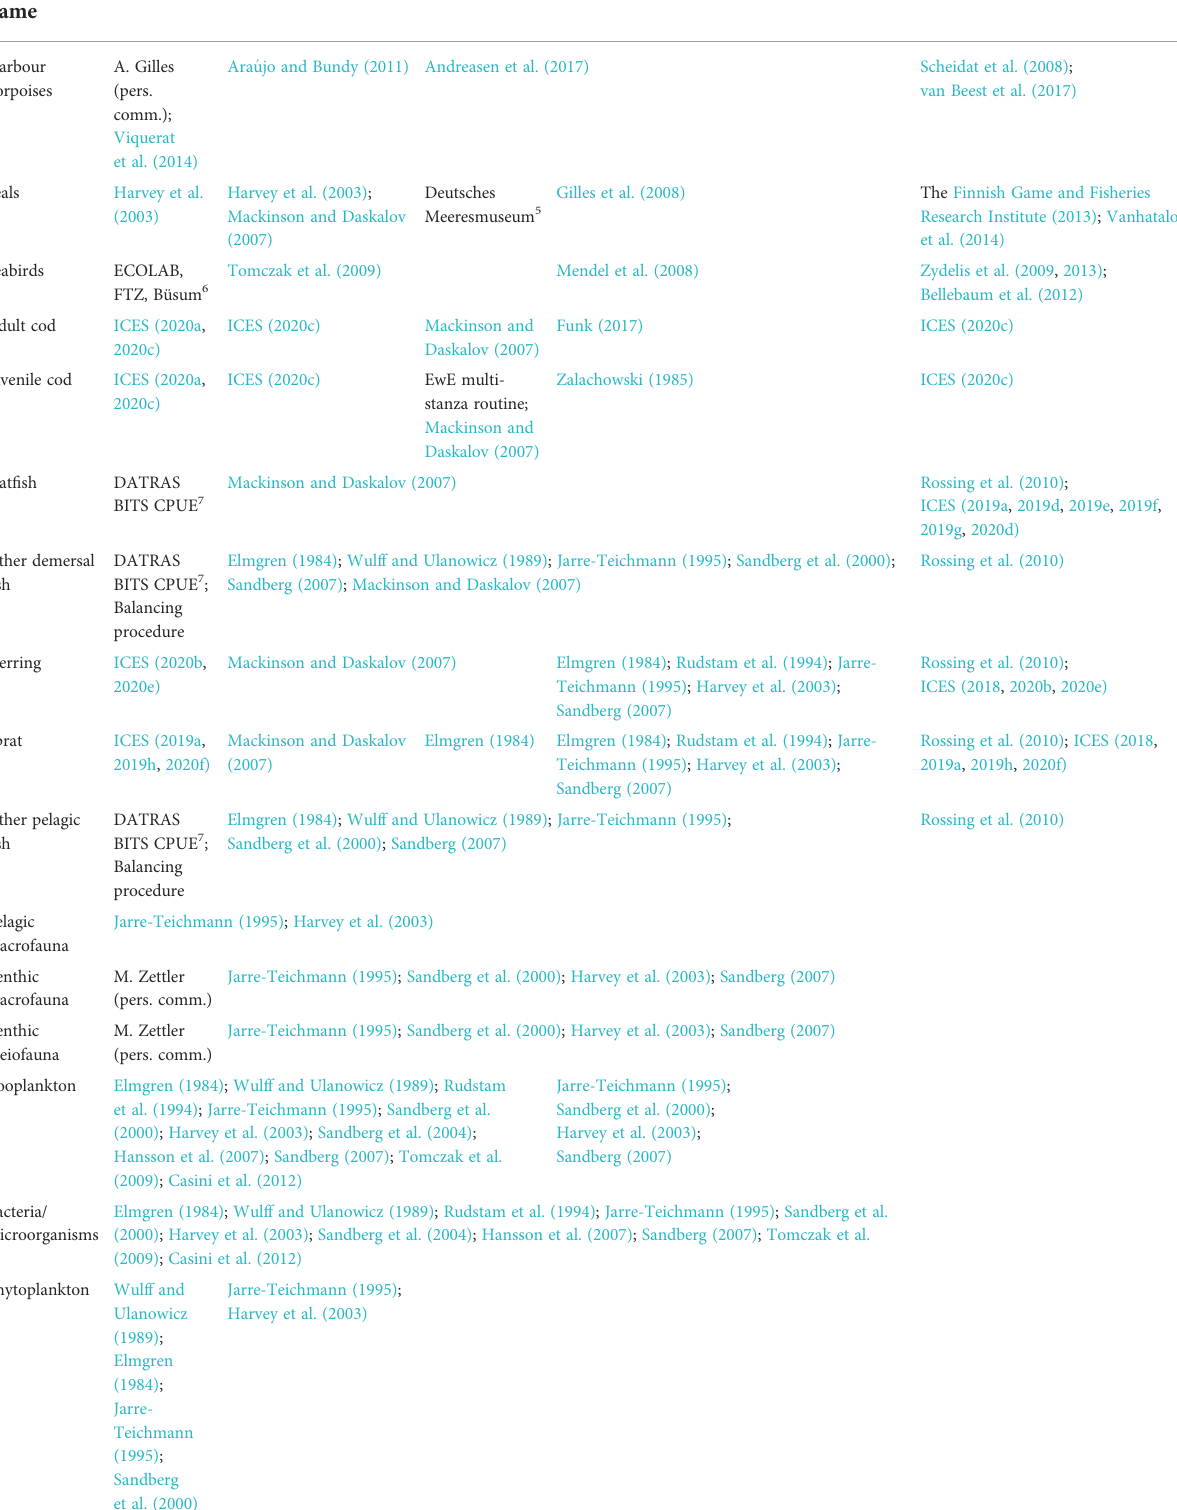
TABLE 1 Sources consulted to retrieve variables and parameters used to build the EwE